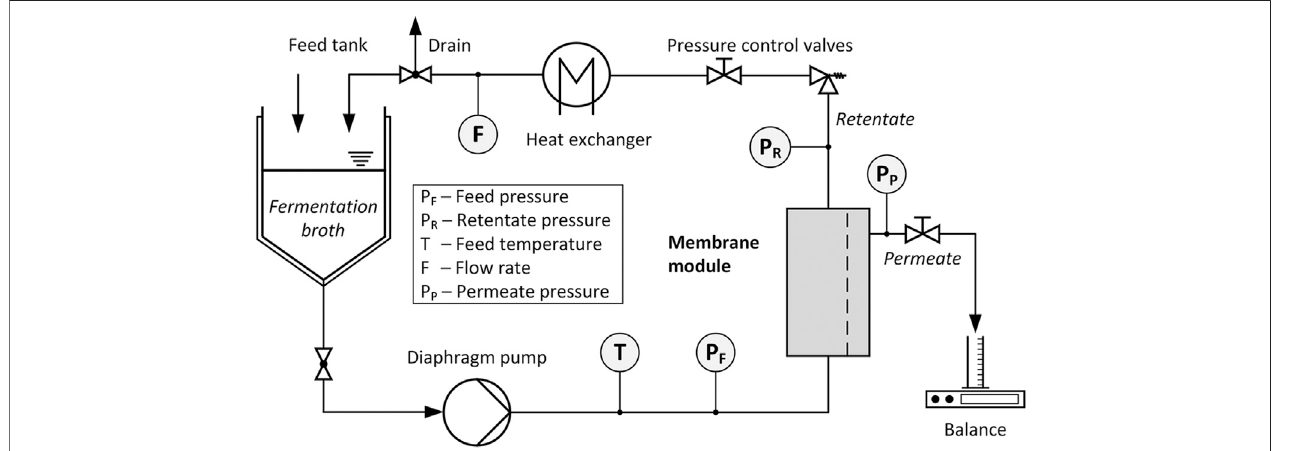
FIGURE 2 | Schematic diagram of the cross fl ow fi ltration